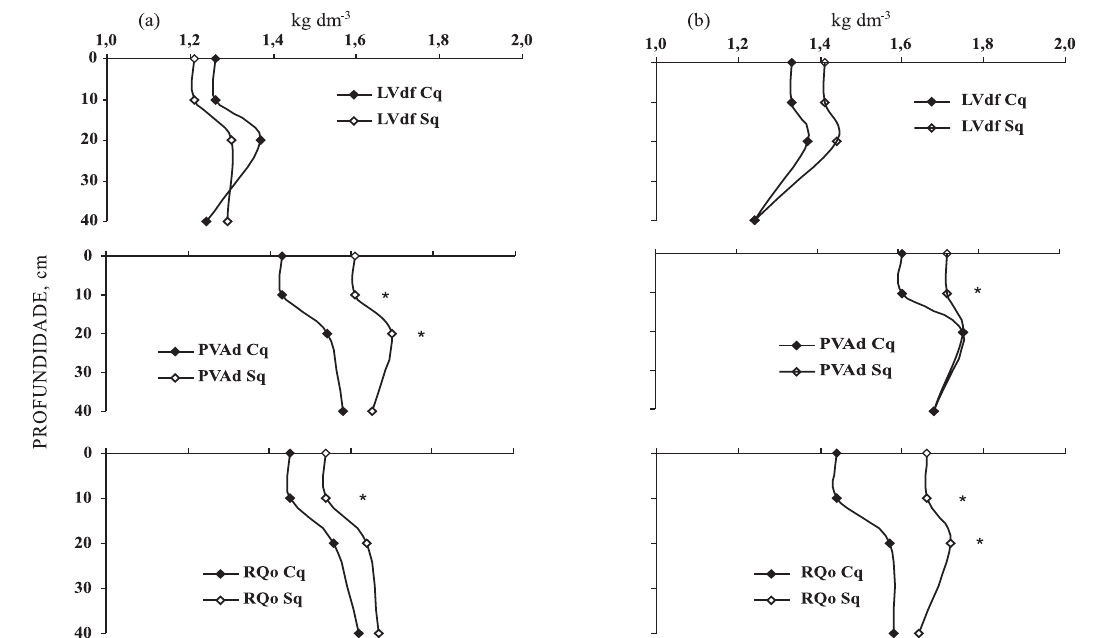
Figura 4. Densidade do solo no Latossolo Vermelho distroférrico (LVdf), Argissolo Vermelho-Amarelo distrófico (PVAd) e Neossolo Quartzarênico órtico (RQo) sob os manejos com queima (Cq) e sem queima (Sq) de canavial nas diferentes profundidades. (a) linhas de plantio, (b) entrelinhas de plantio. * Diferença estatística entre tratamentos na mesma profundidade, de acordo com o teste t